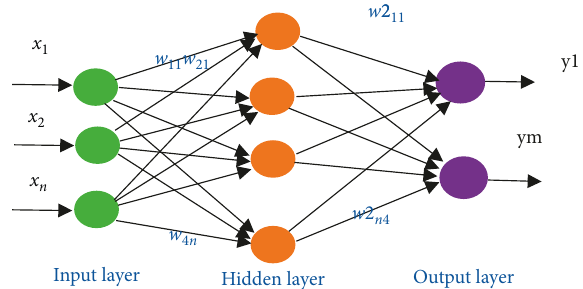
Figure 2: Neural network system [30].